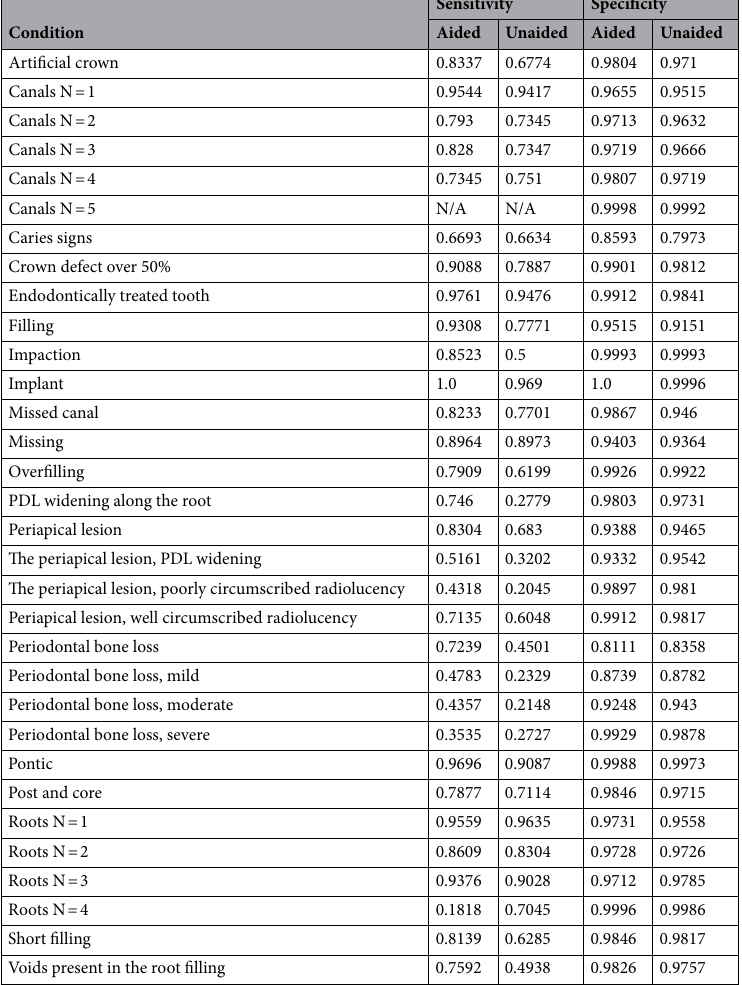
Table 5. Sensitivity and specificity by condition for aided and unaided AI system